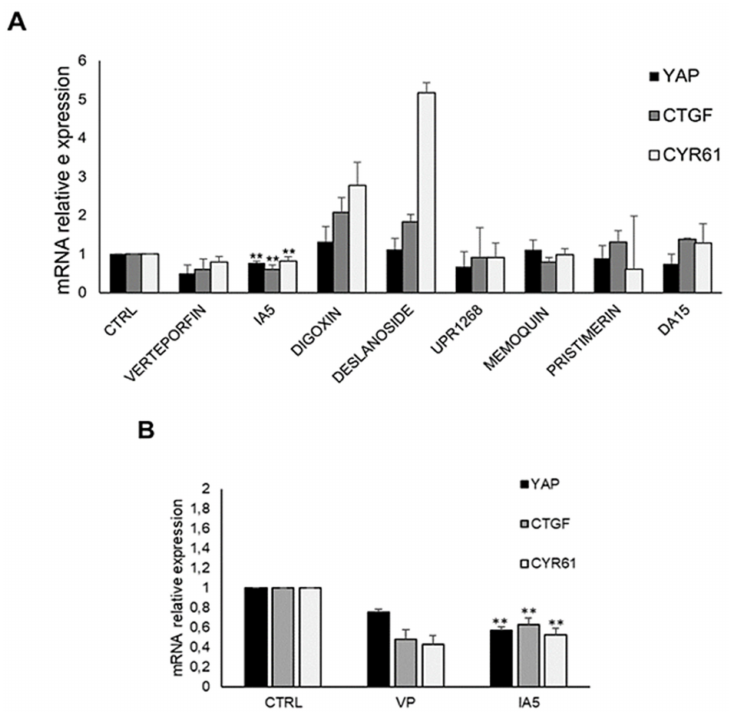
Figure 8. YAP mRNA levels and its target genes decreased after treatment with IA5 in colorectal cancer cells. ( A ) Histogram showing the effects of the seven selected compounds on HCT116 cells, and ( B ) histogram representing the quantification of mRNA level in HT29 cells treated with IA5 . Verteporfin was used as a reference compound. Error bars represent s.d. (n = 3); ** p value <